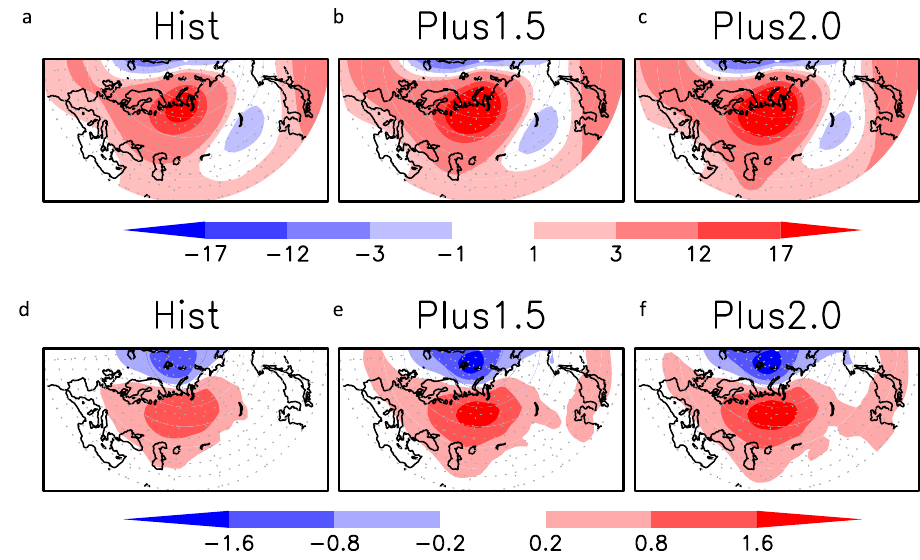
Fig. 3 The regression coef fi cient of pressure under different scenarios. a – c The averaged regression coef fi cients of geopotential height at 500hPa with respect to the Barents-Kara sea (30° – 70°E, 70° – 80°N) near-surface temperature from 5 models with 100-ensembles in HAPPI experiment Hist, Plus1.5 and Plus2.0 scenarios. d – f The averaged regression coef fi cients of surface pressure with respect to the Barents-Kara sea near-surface temperature from 5 models with 100-ensembles in HAPPI experiment Hist, Plus1.5 and Plus2.0 scenarios. Table 1. The granger causality results between the Barents-Kara Sea (BKS) temperature and East Asia (EA) temperature in ERA-interim and HAPPI experiment.